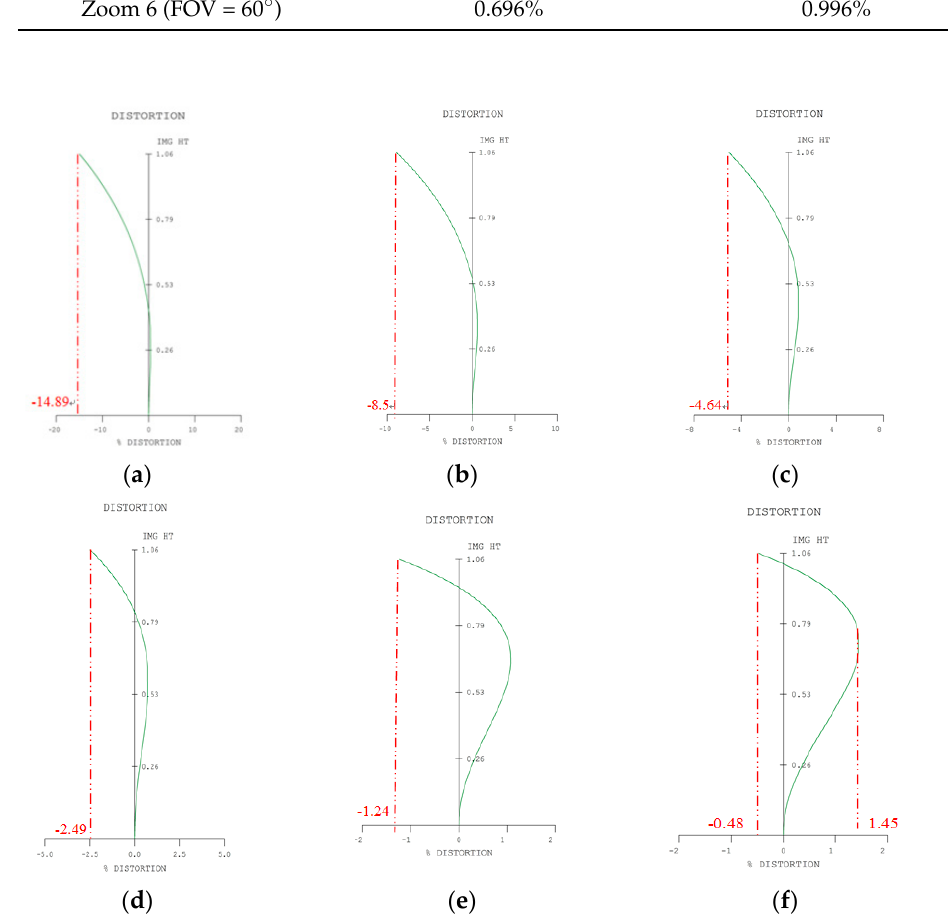
Figure 5. Optical distortion curves of a 2× zoom lens at different magnifications: ( a ) M = − 0.0845; ( b ) M = − 0.0984; ( c ) M = − 0.1150; ( d ) M = − 0.1317; ( e ) M = − 0.1482; ( f ) M = − 0.1690. Table 3. Comparison of horizontal and vertical video distortion at different magnifications.